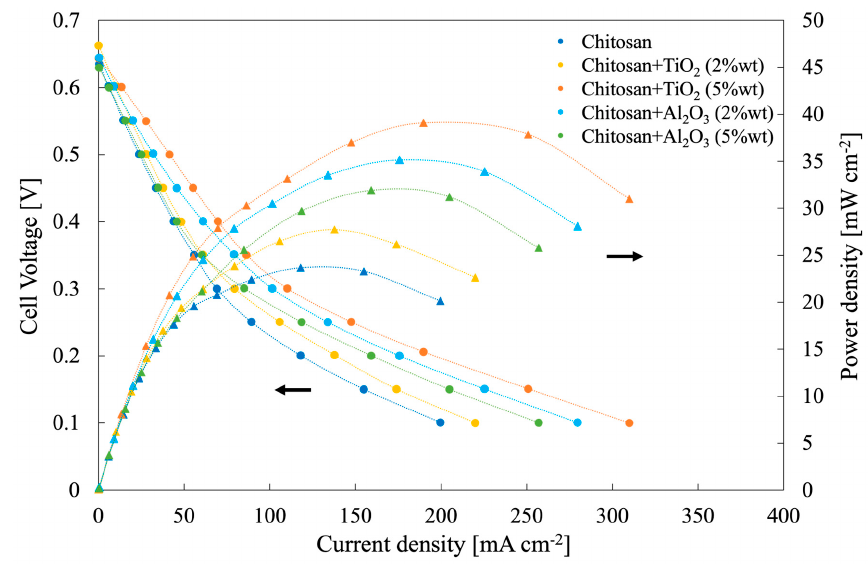
Figure 9. Polarization and power density curves related to a single module DMFC of 1 cm 2 as active area, employing all the synthesized membranes, operating at 50 °C and fed with 2 M methanol aqueous solution at the anode and oxygen at the cathode.